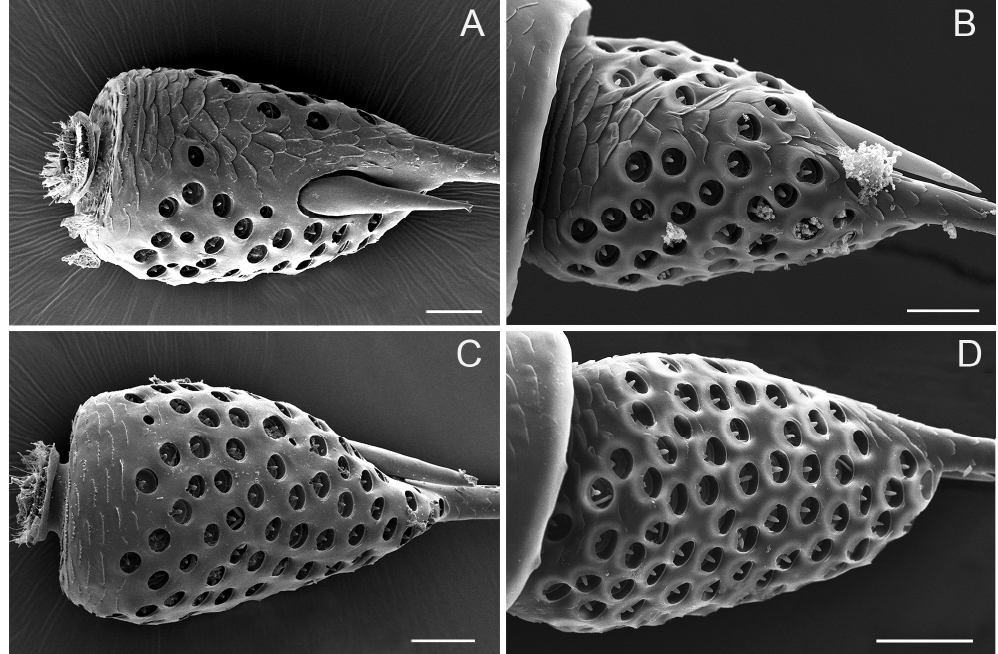
Figure 6. SEM micrographs showing a bulb-shaped portion of flagellum in an adult male Callitettix versicolor’s (Fabricius) antenna. ( A ) Ventral side; ( B ) Anterior side; ( C ) Dorsal side; ( D ) Posterior side. Scale bars: A, B, C, D = 25 μm.